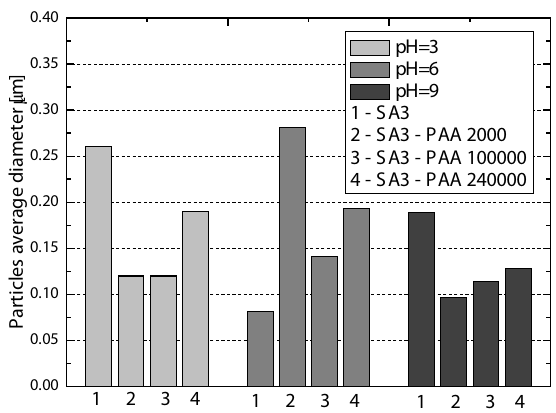
Figure 4. The TSI indexes for SA 3 suspension in the absence and presence of polyacrylic acid at different solution pH.